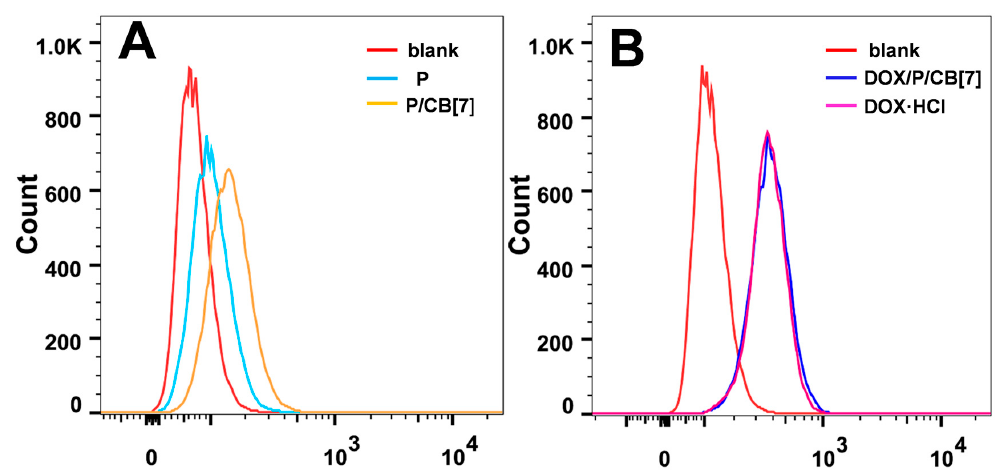
Figure 7. The flow cytometry results of HeLa cells treated with mPEG- b -QP4VP (P) and pseudopolyrotaxanes (P/CB[7]) ( λ em = 432 nm) ( A ), and DOX · HCl and DOX/pseudopolyrotaxanes (DOX/P/CB[7]) after incubation for 4 h ( λ em = 590 nm) ( B ). (The DOX concentration is 10 μ g/mL).